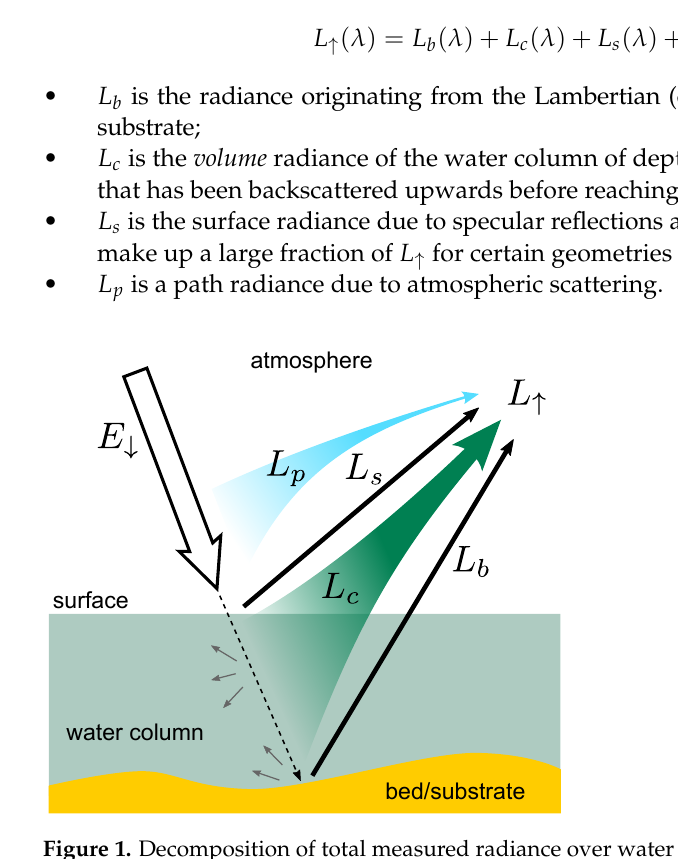
Figure 1. Decomposition of total measured radiance over water (adapted from Campbell, 1996 [9]). E ↓ is the downwelling solar irradiance (W · m − 2 ), L b , L c , L s and L p are the bed, water column, surface and path radiances, respectively (W · m − 2 · sr − 1